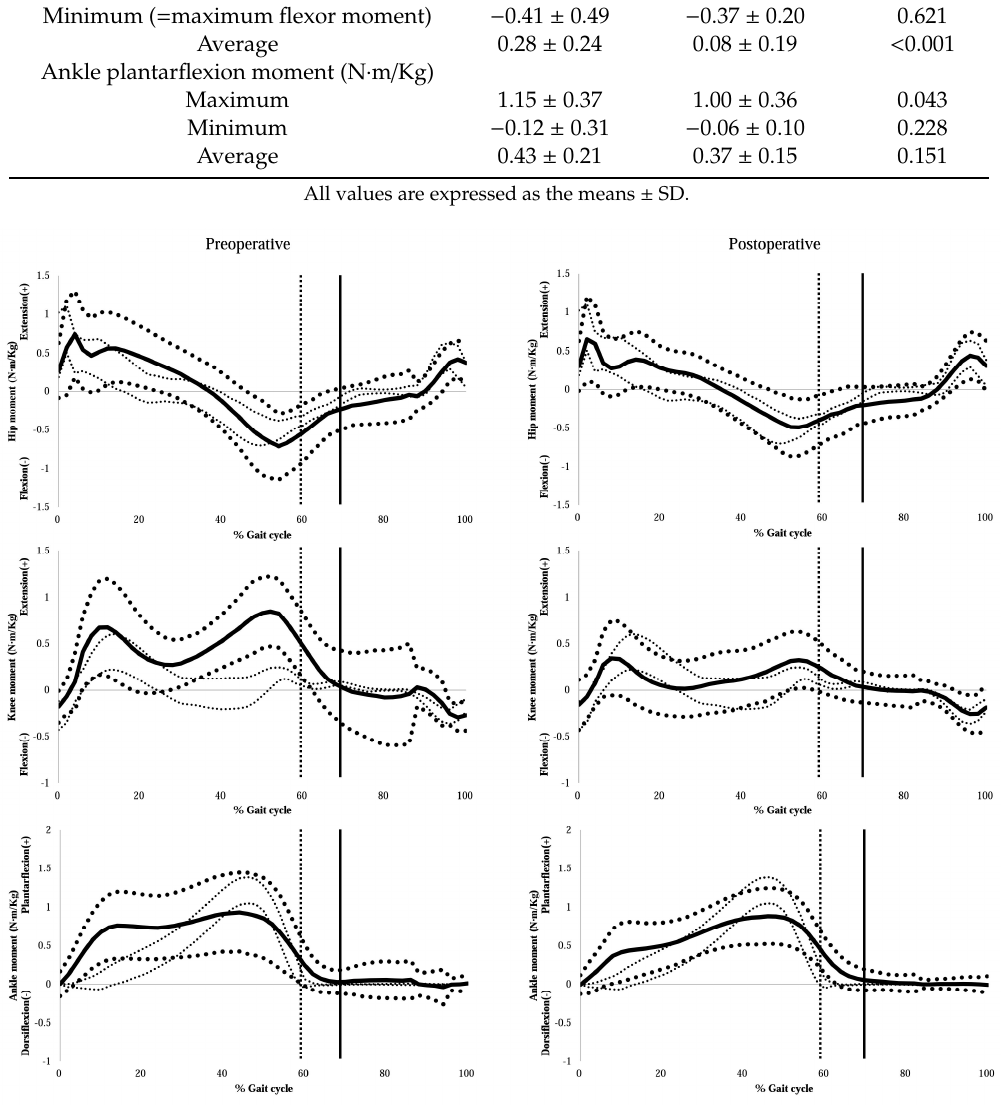
Figure 4. Preoperative and final follow-up sagittal plane kinetic graphs. Bold solid lines indicate average values. Bold dotted lines represent one standard deviation. Fine dotted lines indicate the normal range.